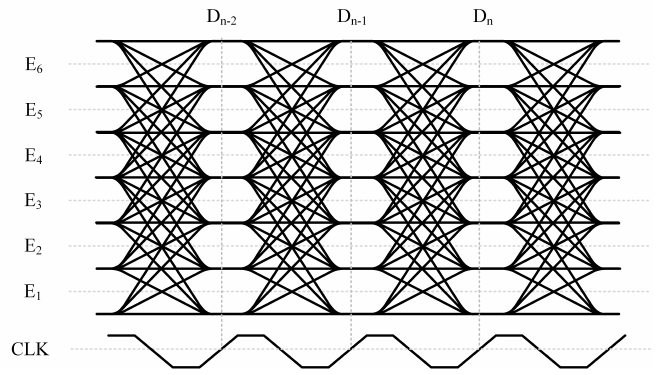
Figure 3. Eye diagram of DB PAM-4 with 3